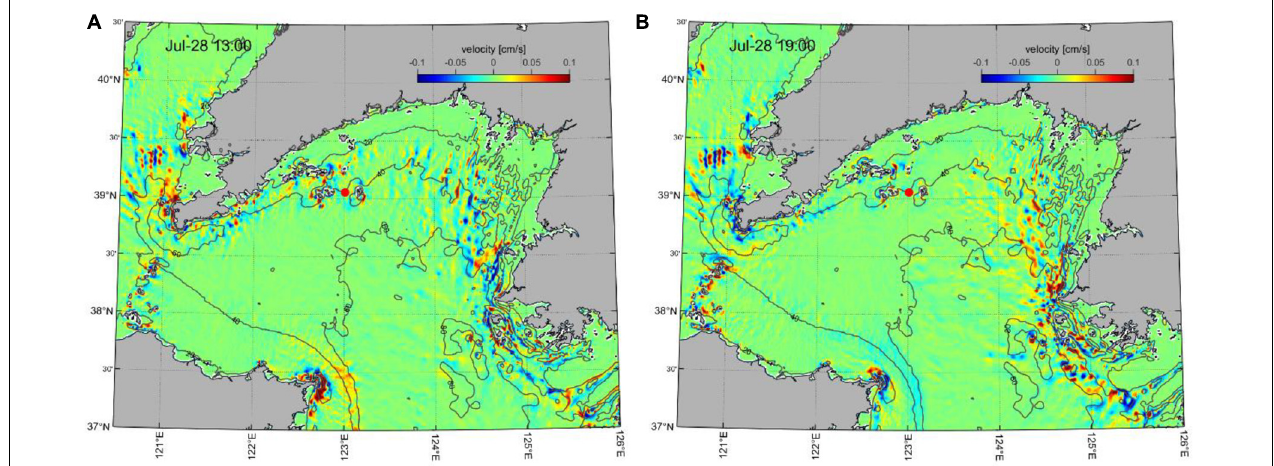
FIGURE 10 | Simulated vertical velocity difference (cm/s) at 10 m depth for (A) 13:00 July 28 and (B) 19:00 July 28, computed from baroclinic and barotropic simulations forced with the M 2 tidal component at the boundary. Solid lines represent the isobath contours of 20, 40, 60, and 80 m. The red dot represents the ADCP mooring location.